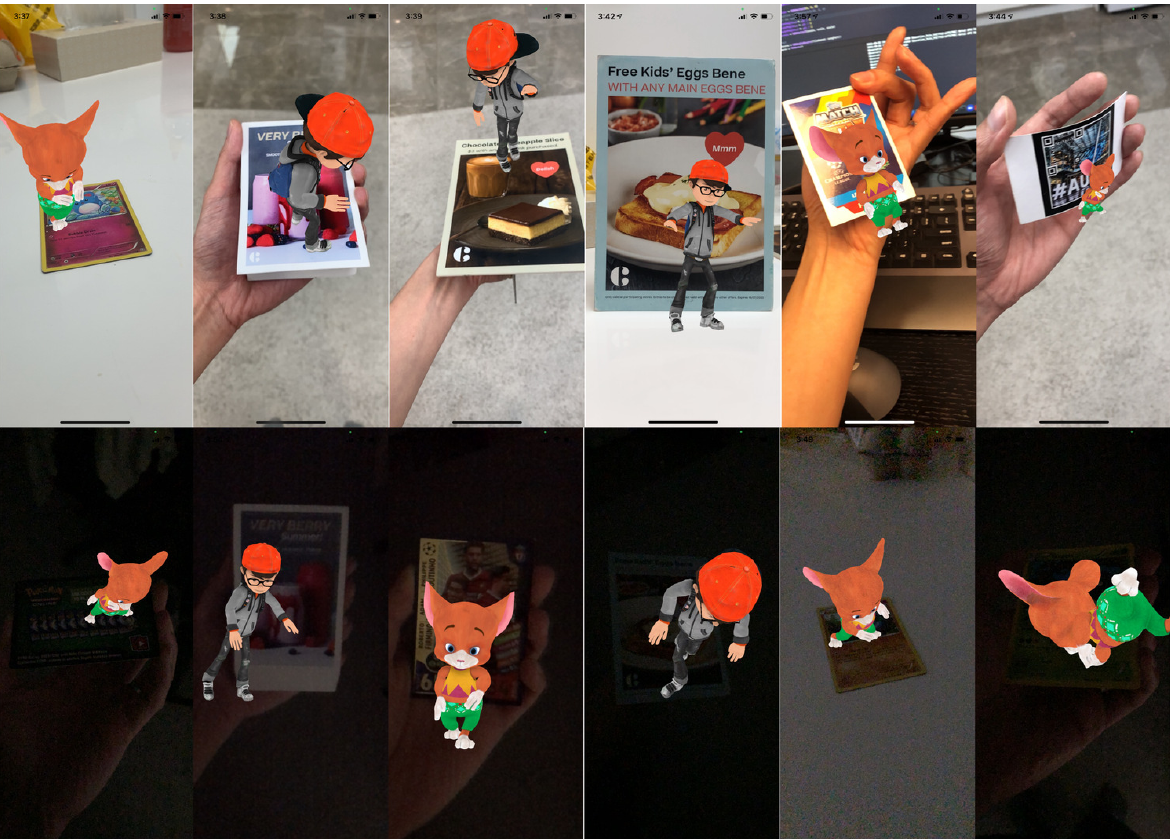
Figure 18. The prototype iOS application shows that the proposed method can predict the augmented reality markers under different lighting conditions and successfully render the corresponding virtual